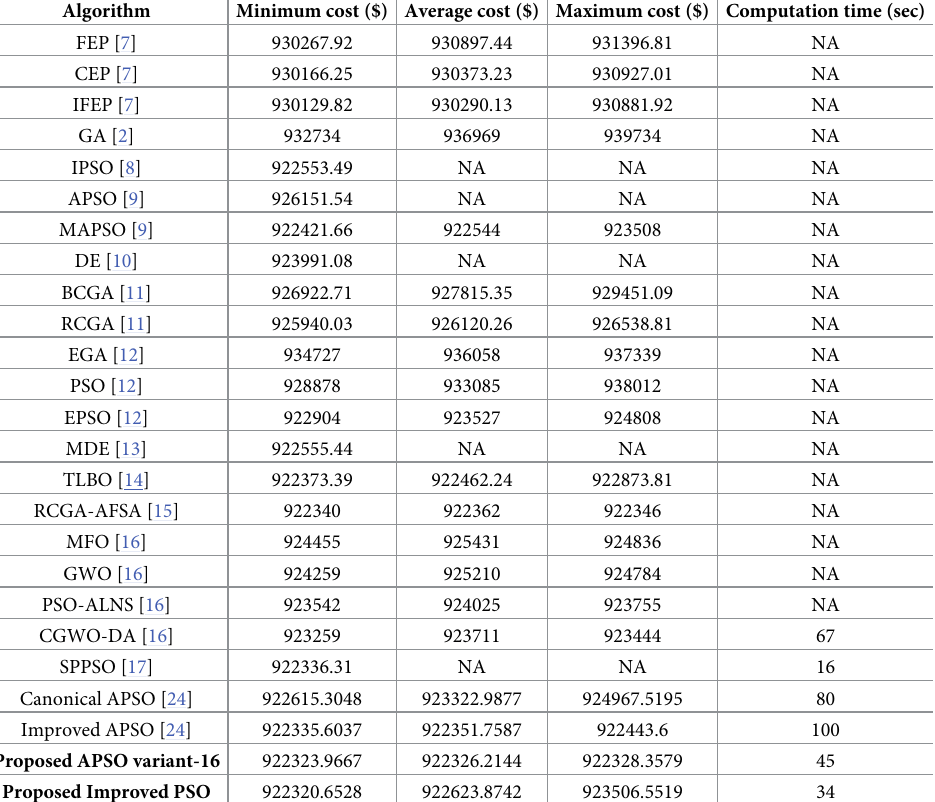
Table 12. Comparison of cost obtained by implementation of different algorithms on the CSTHTS problem.